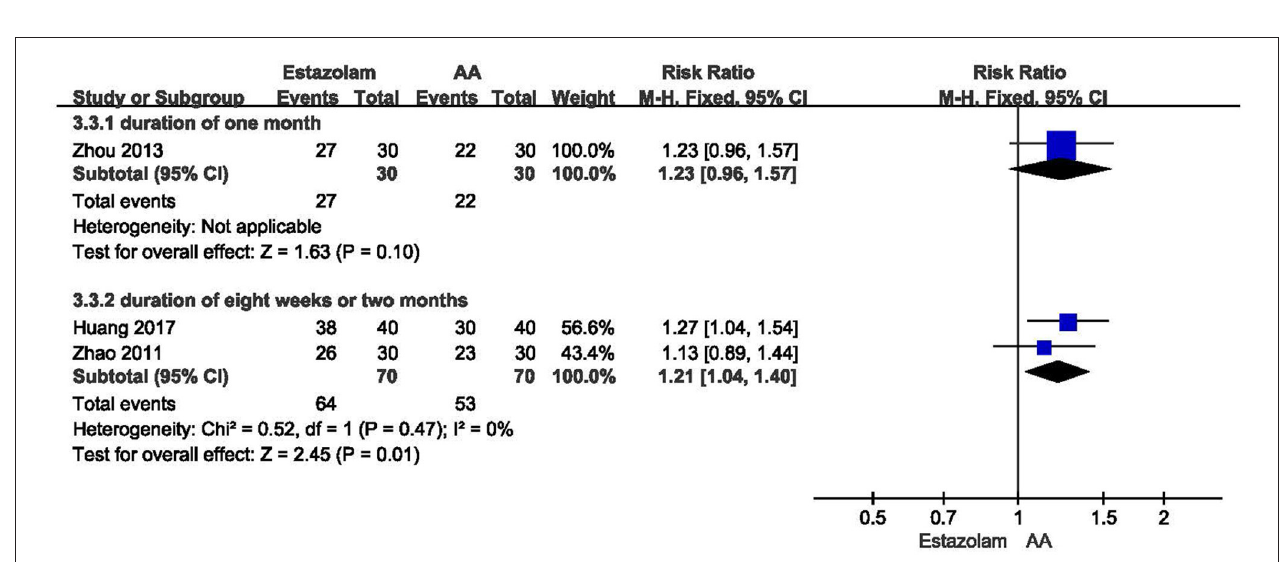
FIGURE 4 | Meta-analysis of AA vs. estazolam on PSQI global score.